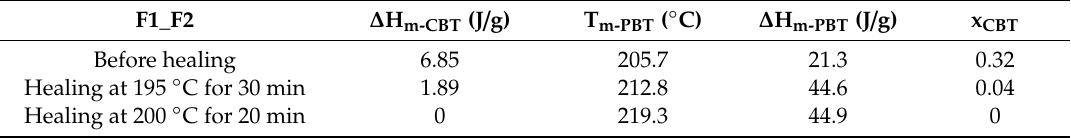
Table 3. Melting enthalpies and residual amount of CBT before and after healing of F1_F2 system. F1_F2 ∆ H m-CBT (J / g) T m-PBT ( ◦ C) ∆ H m-PBT (J / g) x CBT Before healing 6.85 Healing at 195 ◦ C for 30